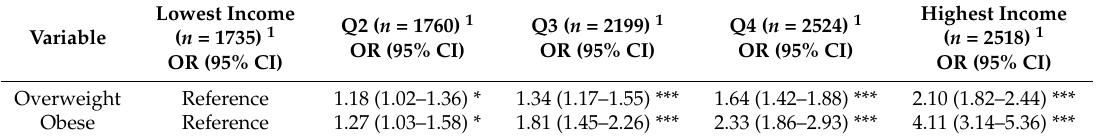
Multinomial logistic regression associations between family income quantiles and weight